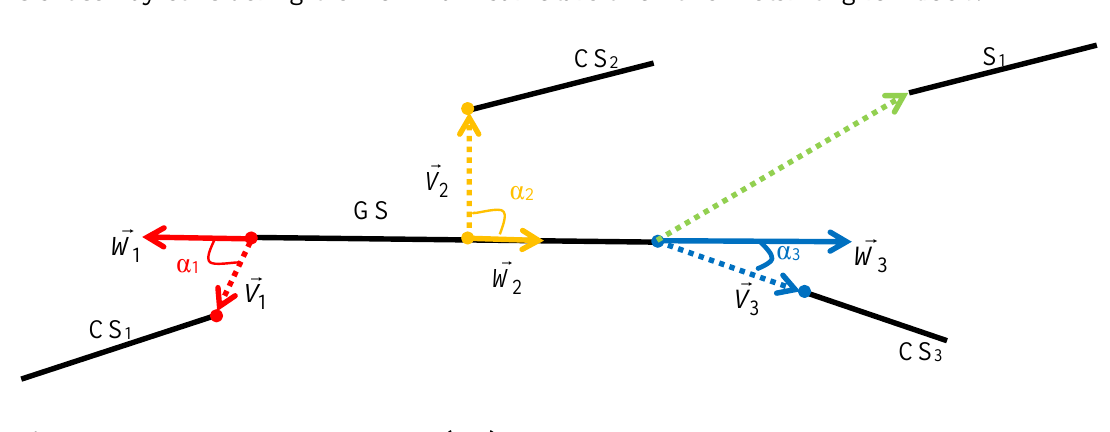
Figure 7. The growing rail segment (GS) would be merged only with candidate segment three (CS 3 ) since other candidate segments are either too far from GS or they are not in line with